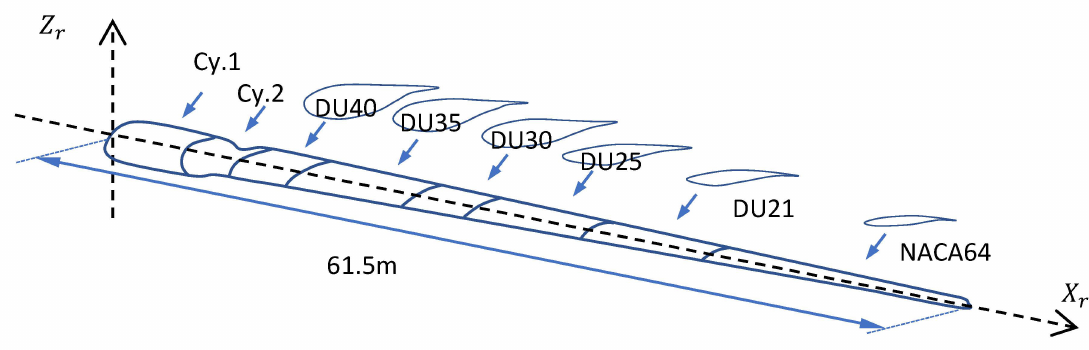
Figure 1. Schematic of the 5 MW NREL blade.